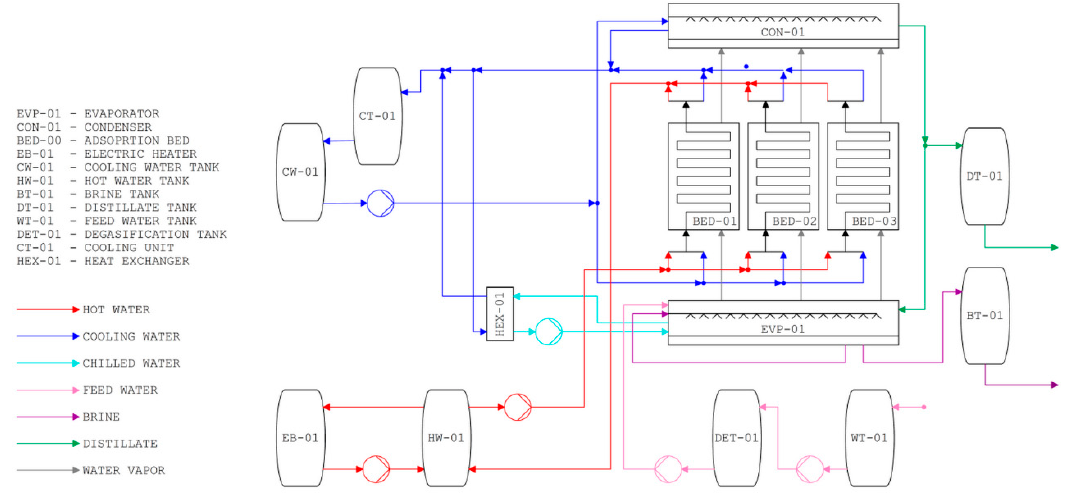
Figure 2. Scheme of adsorption chiller with desalination function at the Center of Energy AGH.